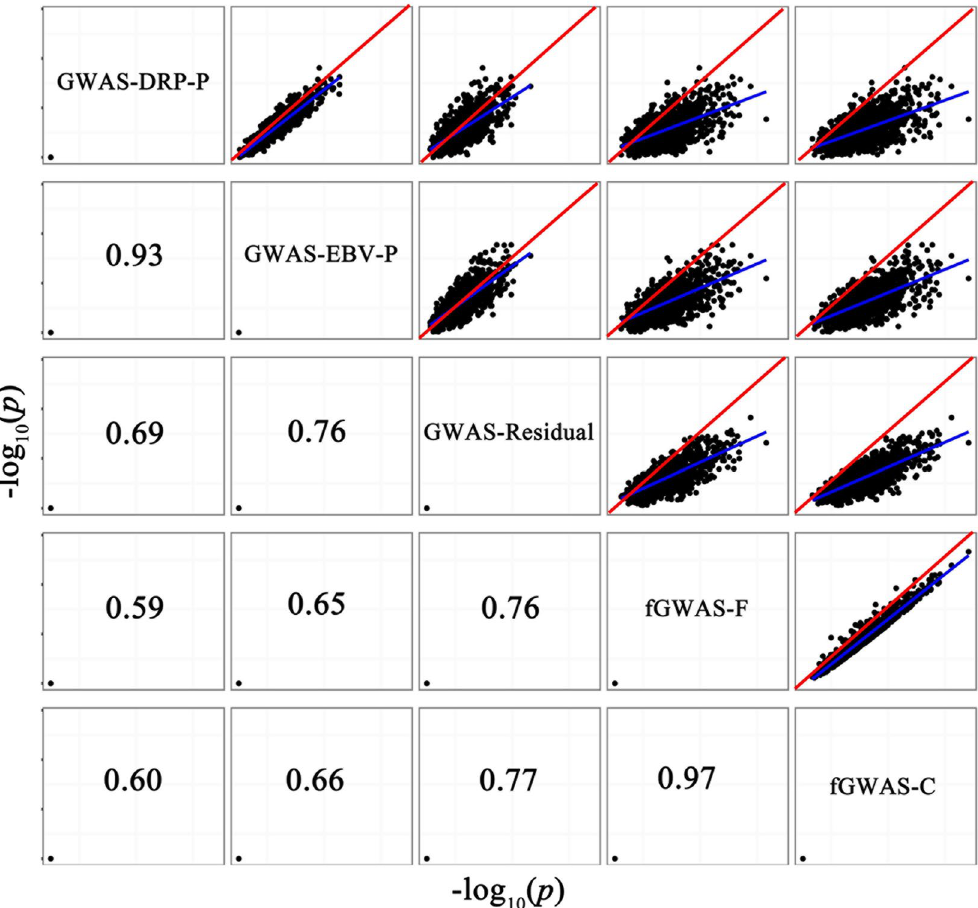
Figure 3. Comparison of p -values ( − p log ( ) ) using different GWAS models at QTN heritability of 1.0% for the 10 simulation study. Scatterplots of − p log ( ) for any two GWAS models were shown at the upper triangular, with 10 Pearson correlation coefficients listed at the lower triangular. The read lines represented regression line y = x; the blue lines were the lines of best fit for − p log ( ) of each two models. 10